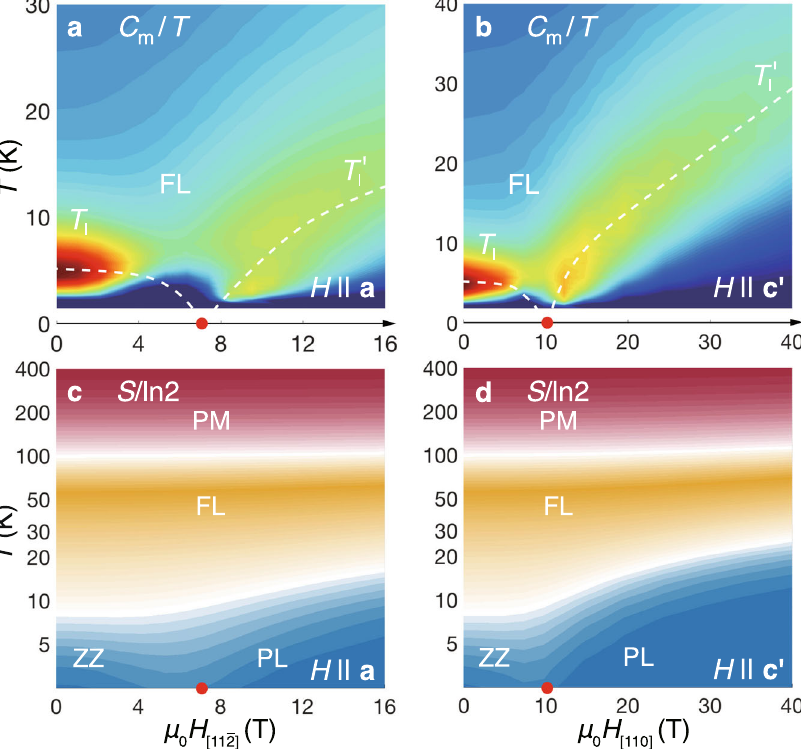
Fig. 4 Contour plots of C m / T and the isentropes. The magnetic speci fi c heat C m / T under H ½ 11 (cid:1) 2 (cid:3) k a and H ½ 110 (cid:3) k c 0 are shown in ( a ) and ( b ), respectively. The white dashed lines indicate the low-temperature scale T l and T 0 and are guides for the eye. The red dots on the T = 0 axis denote the QPT at h c and h c ’ 10 T. The isentropes along the two fi eld directions are shown in ( c ) and ( d ), where we fi nd an intermediate regime with fractional thermal ½ 110 (cid:3) entropies (cid:7) ð ln2 Þ =